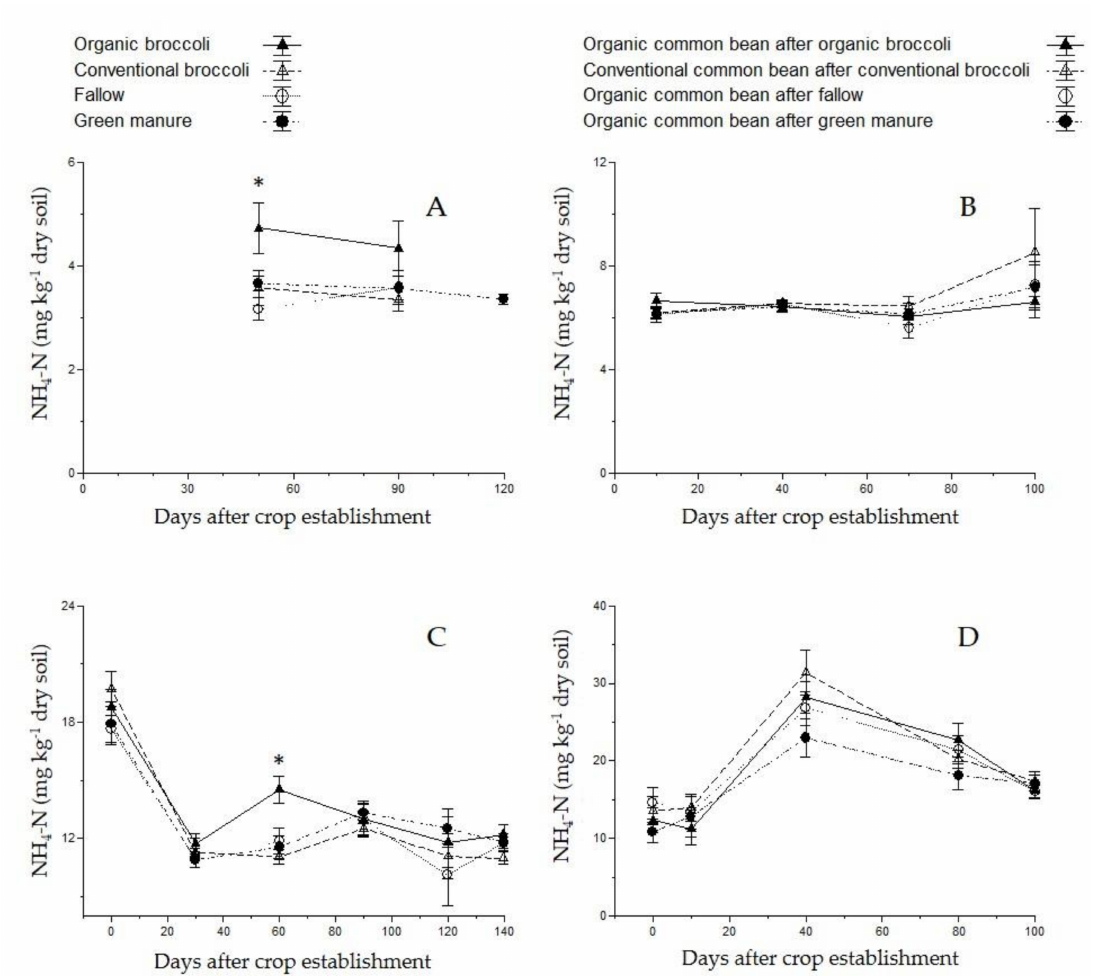
Figure 6. Impact of pre-crop treatments during the wintertime on NH 4 -N concentration in the soil during the two experimental years. Vertical bars indicate standard errors of means (n = 8), while * indicates significant di ff erences according to Duncan’s multiple range test ( p < 0.05), significant at p < 0.05. ( A ) Soil NH 4 -N concentrations in the di ff erent treatments applied as preceding crops during autumn-winter 2017–2018, particularly at 50, 90, and 120 days after crop establishment (DACE). ( B ) Soil NH 4 -N concentrations after crop establishment, at the 50% flowering stage, during harvest, and at crop termination (10, 40, 70, and 100 DACE) in the common bean crop during spring-summer 2018, as influenced by the preceding winter crop. ( C ) Soil NH 4 -N concentrations before basal dressing, after crop establishment, at the stage of broccoli flower head formation, at crop termination of broccoli, at 50% flowering of faba bean, and after incorporation of plant residues into the soil (0, 30, 60, 90, 120, and 140 DACE) in the di ff erent treatments applied as preceding crops during autumn-winter 2018–2019. ( D ) Soil NH 4 -N concentrations before and after the establishment of common bean crop, at the 50% flowering stage, at harvest, and at crop termination (0, 10, 40, 80, and 100 DACE, respectively) during spring-summer 2019, as influenced by the preceding winter